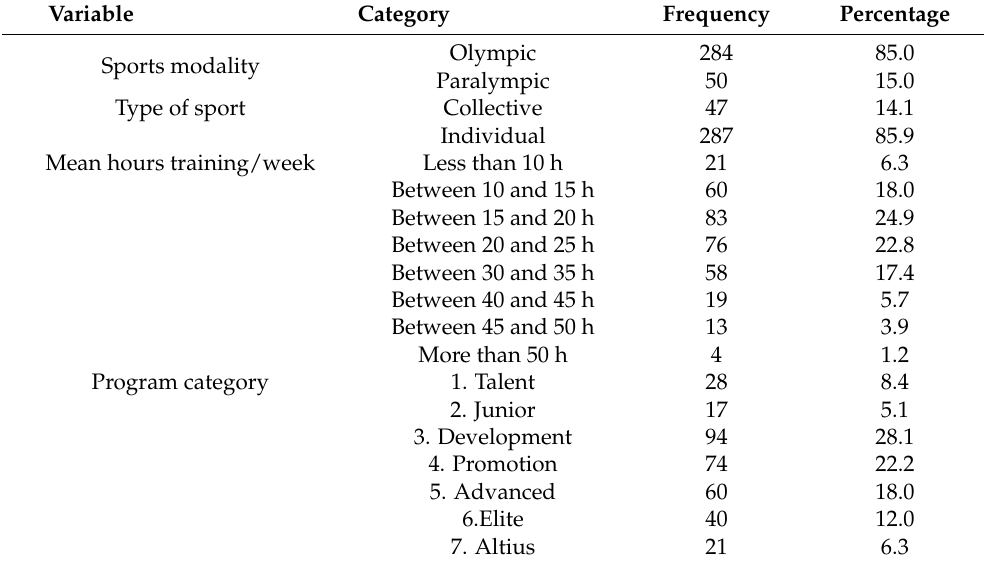
Table 1. Characteristics of the